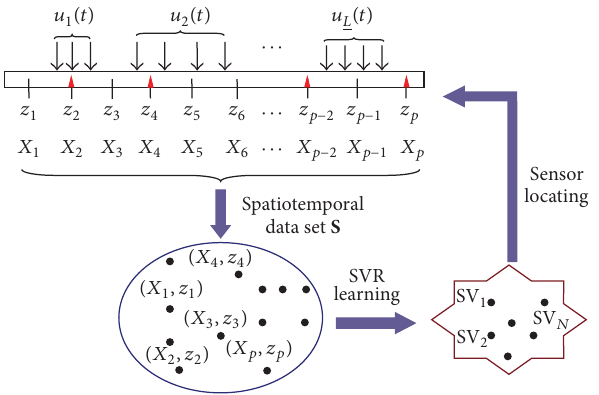
Figure 4: Methodology of SVR learning based sensor placement.